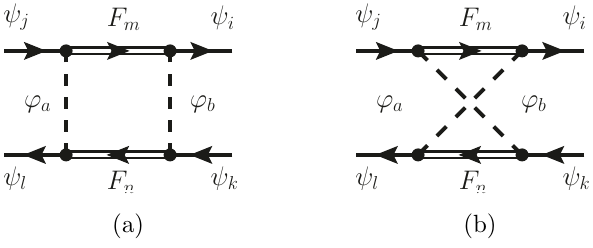
Figure 2. Box graphs for the decoupling of VLQs in representations F m;n due to their Yukawa interactions with scalars ’ = H; S; (cid:8) and SM quarks = ( q L ; d R ; u R ). The crossed graph